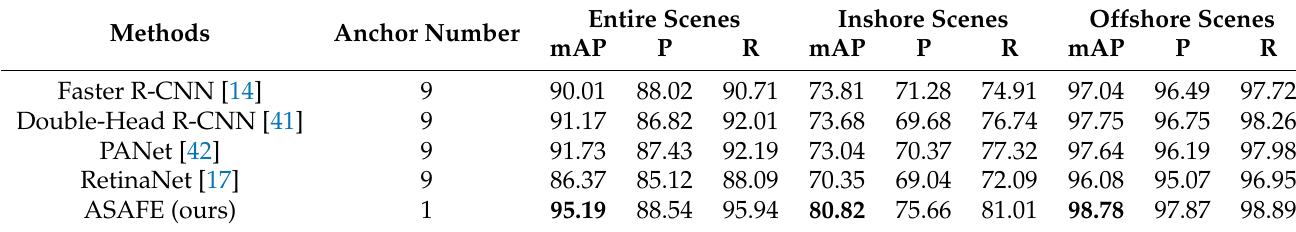
Table 6. Comparisons with different methods on the SSDD